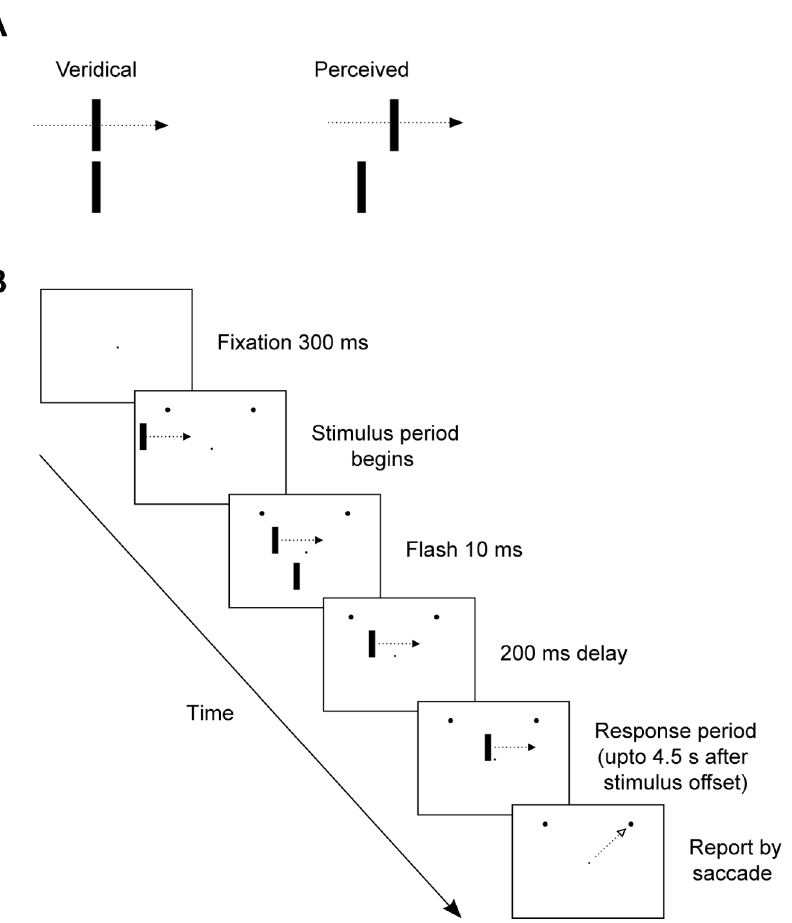
Figure 1. Flash lag illusion and monkey behavioral task. (A) Illustration of the flash lag illusion. A flash that is presented in vertical alignment with a moving bar appears to lag behind the moving bar. (B) The schematic shows stimuli (not drawn to scale) and events in a trial. Stimuli were presented on CRT monitors with a gray background. Subjects fixated for 300 ms after which the stimulus period began. A bright moving bar started to move at a constant speed (10, 14 or 20 u /s) from the left or right end of the monitor display. After the onset of the moving bar, another bar of the same size and luminance was flashed below the moving bar for one video frame (10 ms) at a fixed location. The flash onset time was adjusted to provide different horizontal spatial offsets. For each trial a single spatial offset was chosen randomly from a range of offsets. After a delay of 200 ms from the flash onset, subjects were allowed to report if the flash was located on the right or left side of the moving bar, using a joystick or by saccading to visual targets (illustrated as two black dots in the upper visual field). The next trial began after 1200 ms of inter-trial period.